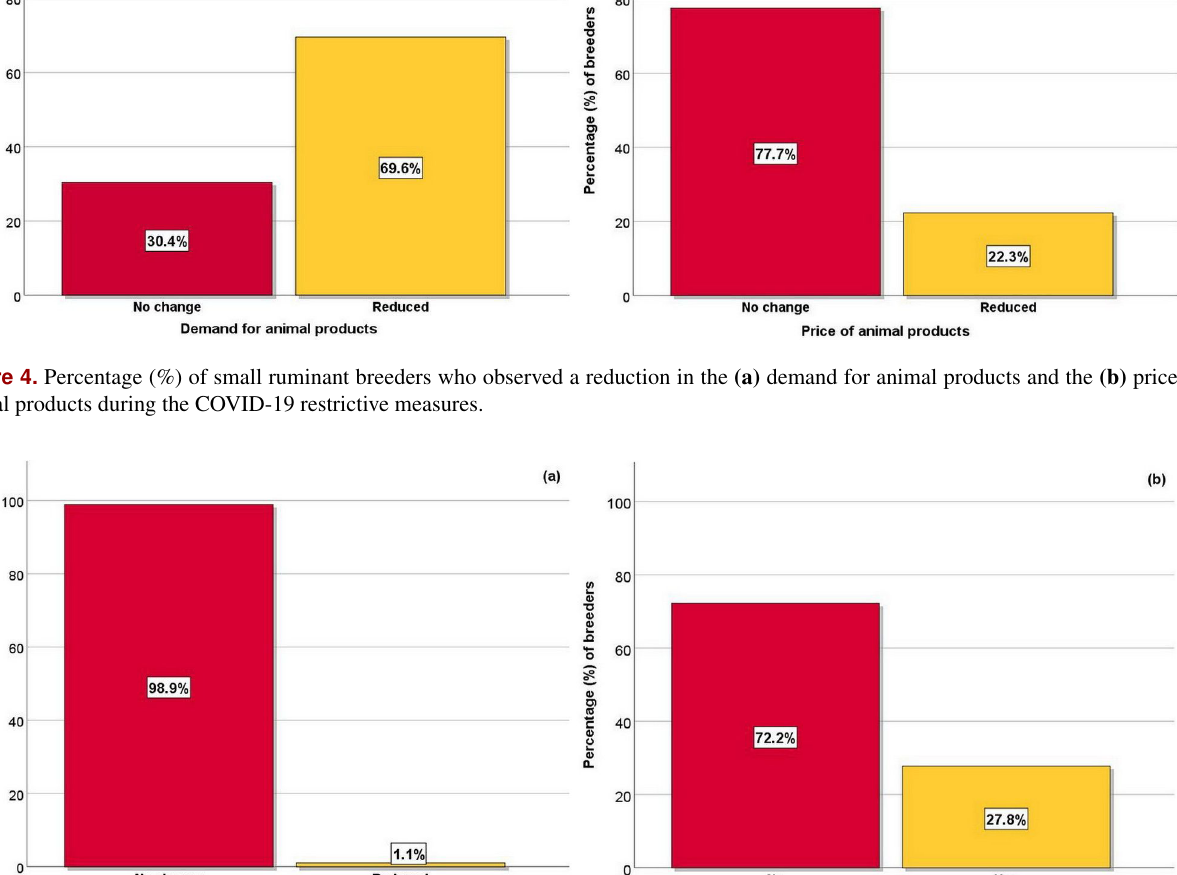
pean Union policy as the engagement of women in